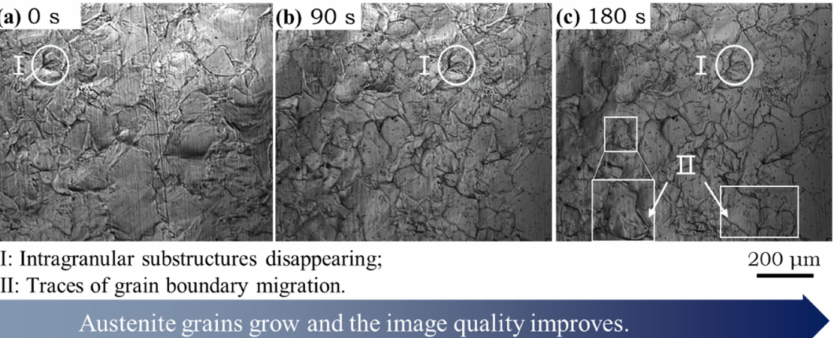
Figure 7. Austenite growth of subrapid solidified sample held at 1300 ◦ C:( a – c ) are snapshots at 0 s, 90 s, and 180 s from 1300 ◦ C,